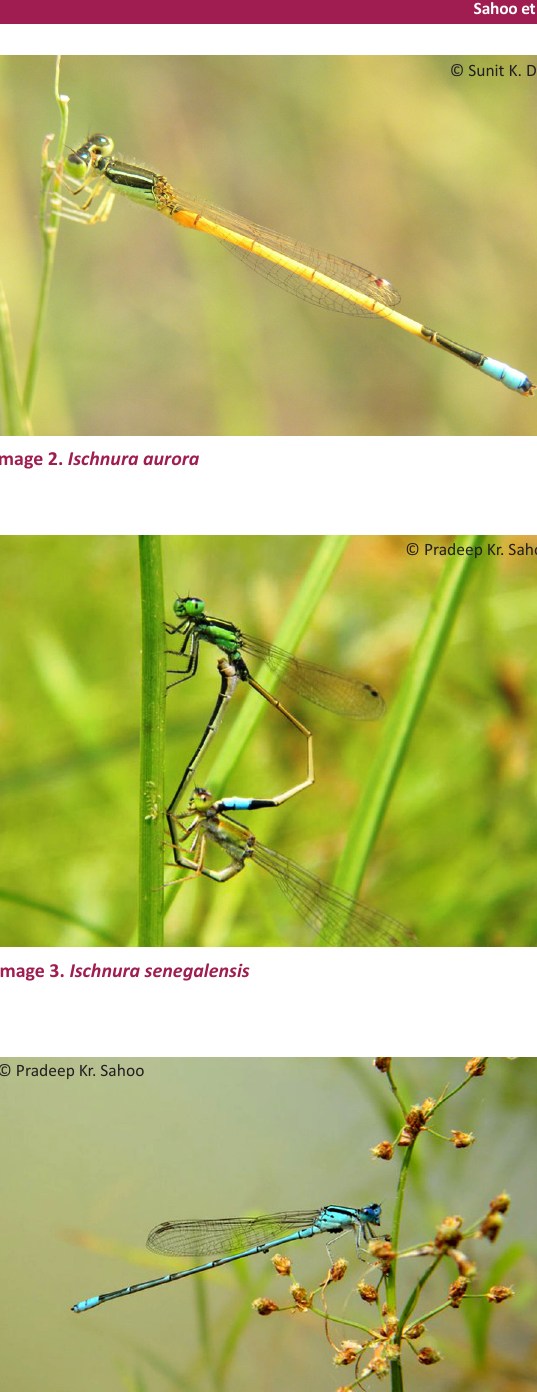
Image 4. Pseudagrion microcephalum